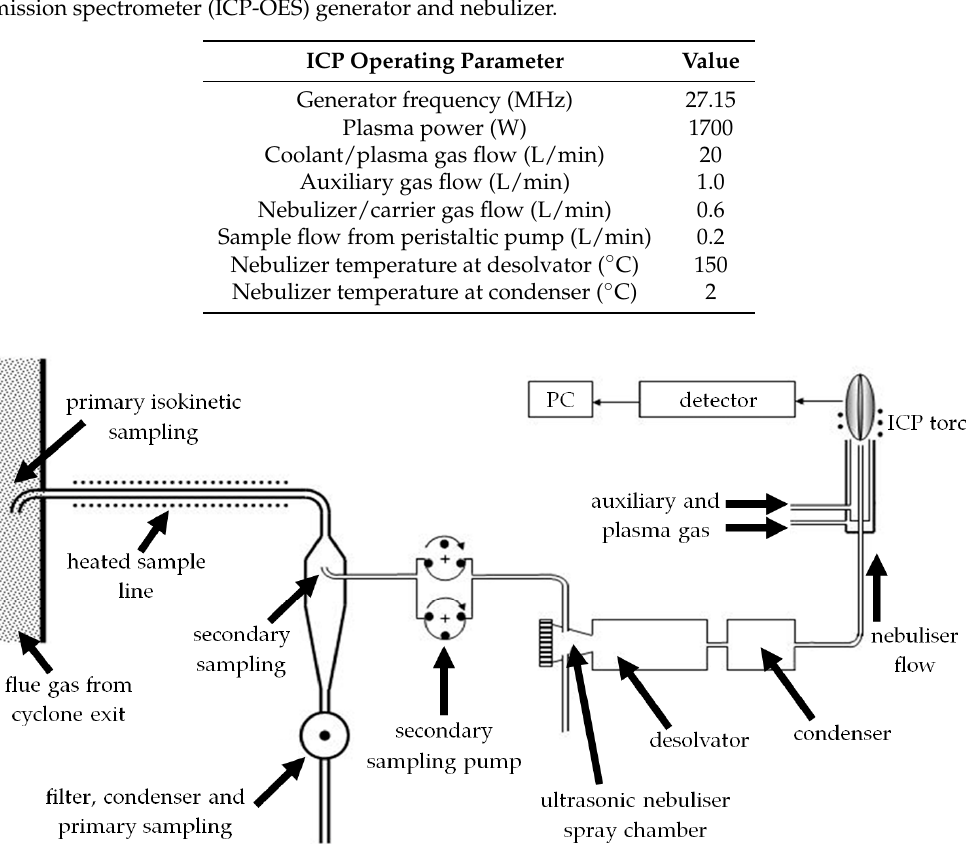
Figure 2. Sampling system for the ICP and the sample introduction pathway to the torch.